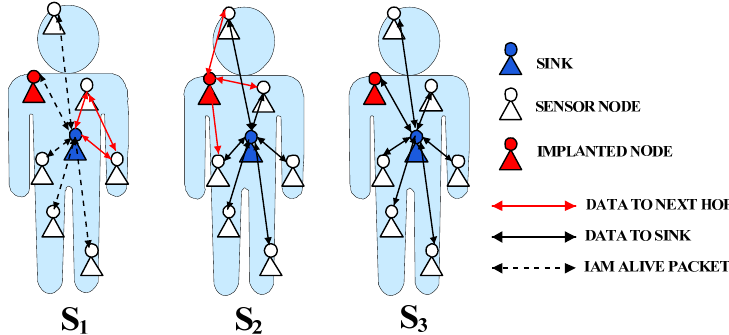
Figure 4. Architecture of the proposed FPLE algorithm.